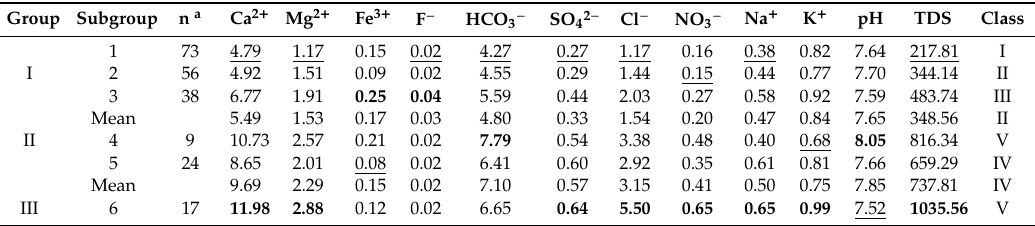
Table 2. Water chemistry of the groups determined from